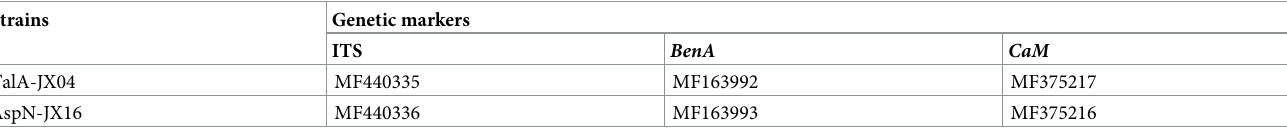
Table 2. Strains with their GenBank accession numbers for three genetic markers. Strains Genetic markers